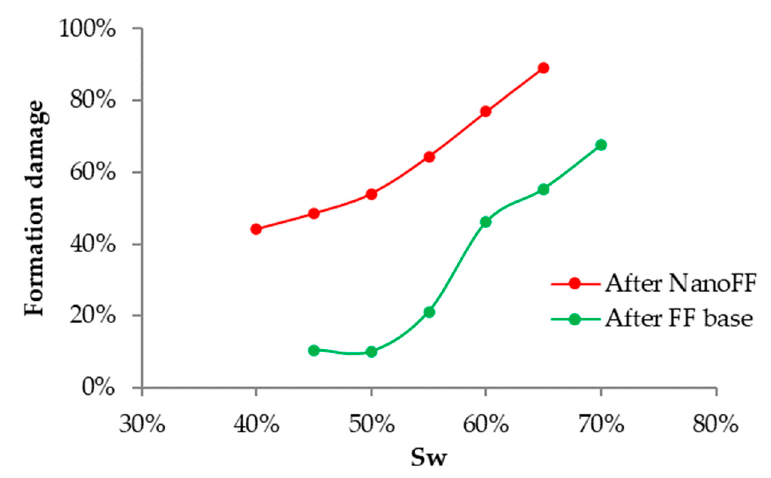
Figure 15. Formation damage behavior at different water saturations for the test carried out with the original and optimized NanoFF in the Castilla oil field porous media.